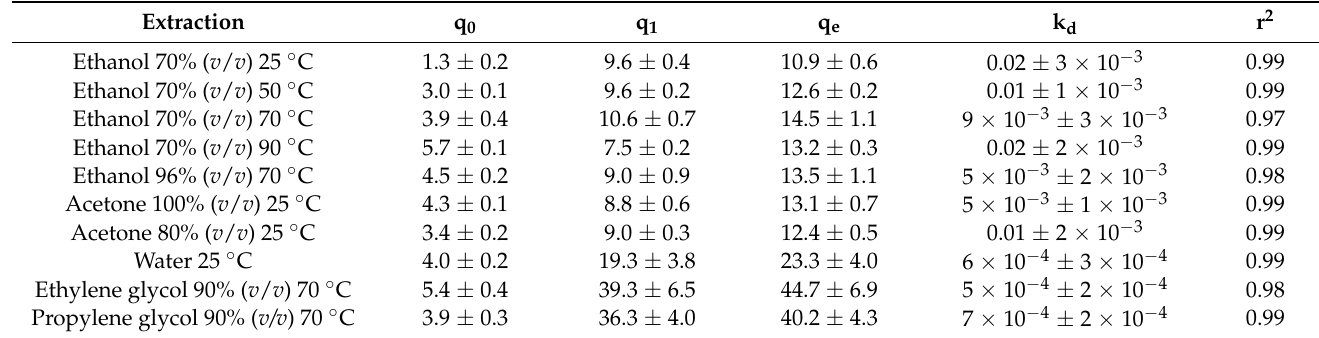
Table 1. Kinetic parameters from the extraction process of AP measuring total phenolic content (TPC) by Folin–Ciocalteu’s method; q 0 , q 1 , and q e are measured in mg GAE/gds, while k d units are gds/(mg GAE · min).